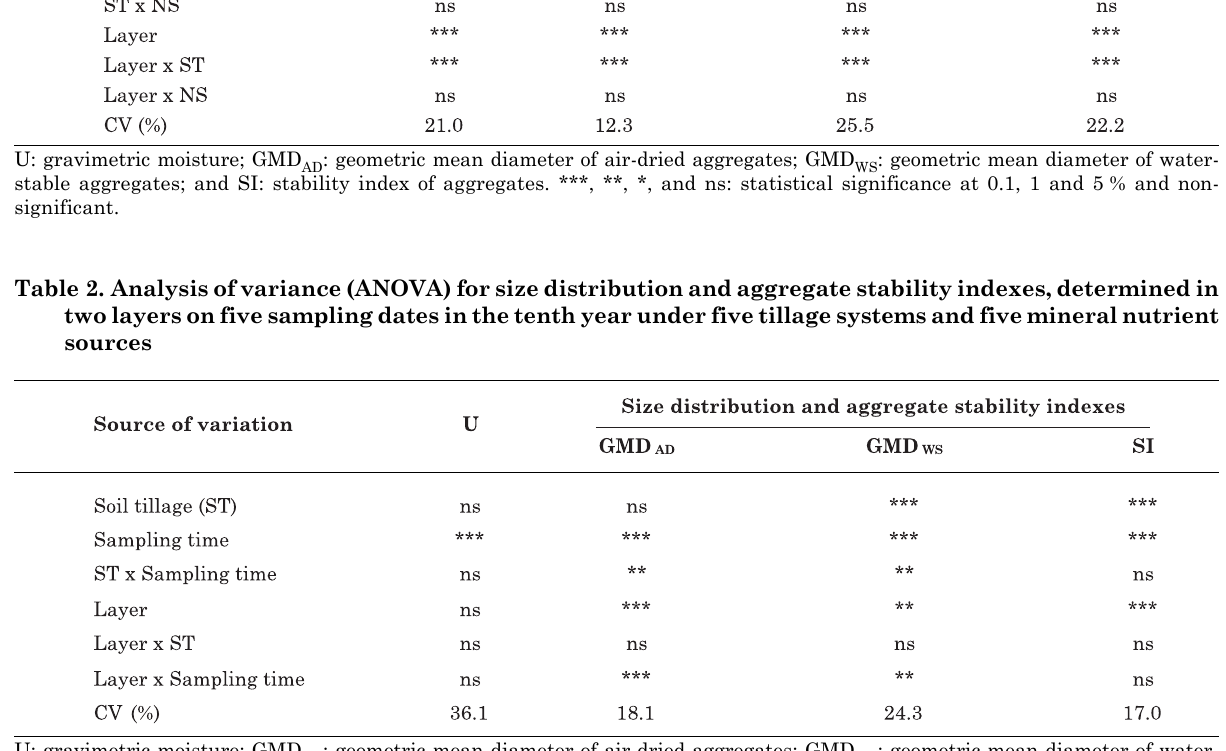
: geometric mean diameter of air-dried aggregates; GMD AD